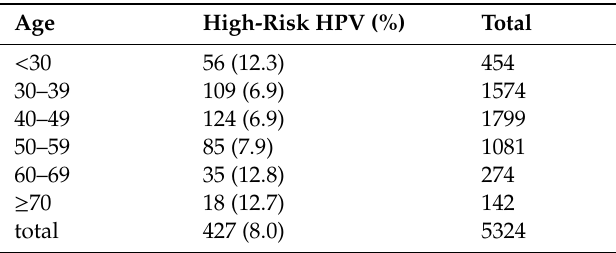
Table 6. Age-related prevalence of HPV in the MyHPV CHIP ™ group.